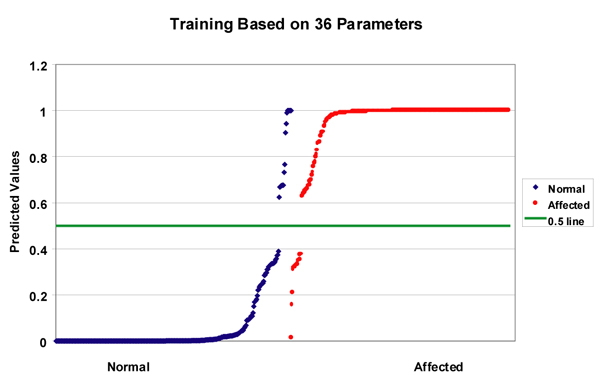
Predicted values and true diagnoses for 650 individuals: full neural network. Individuals diagnosed as normal are shown with blue diamonds, those diagnosed as alcoholics are shown with red circles. The best predictions are represented by values close to zero for normals and close to one for affected individuals.